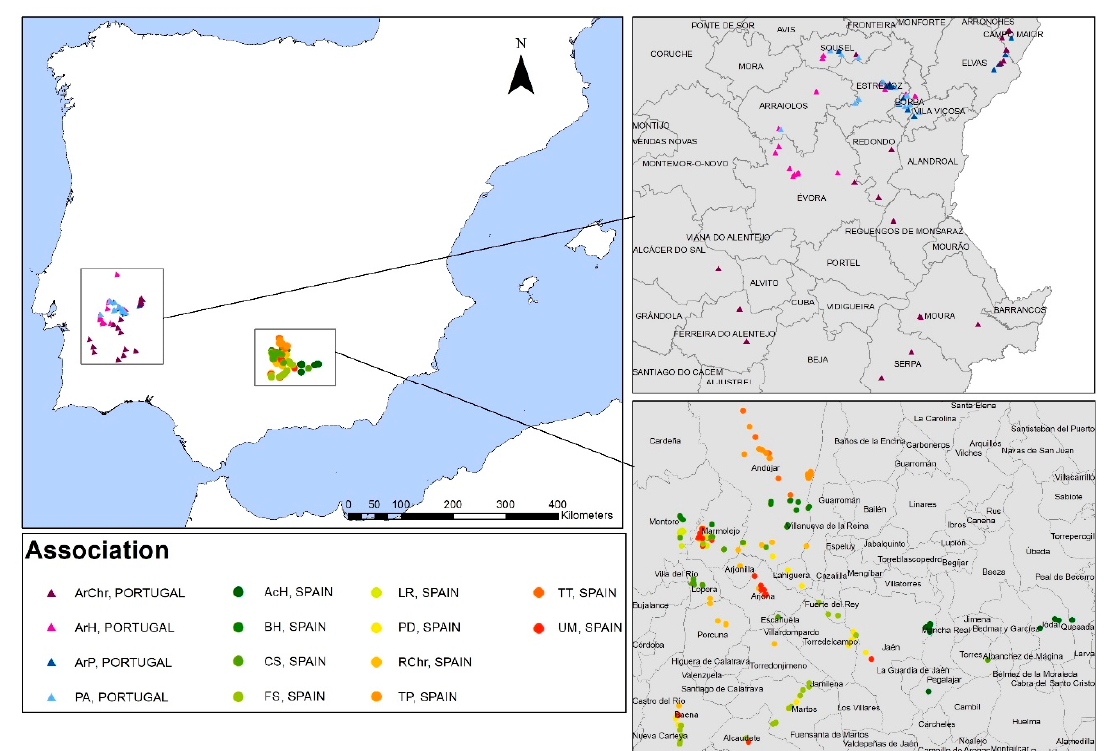
Figure 1. Location of the associations studied in Spain and Portugal.